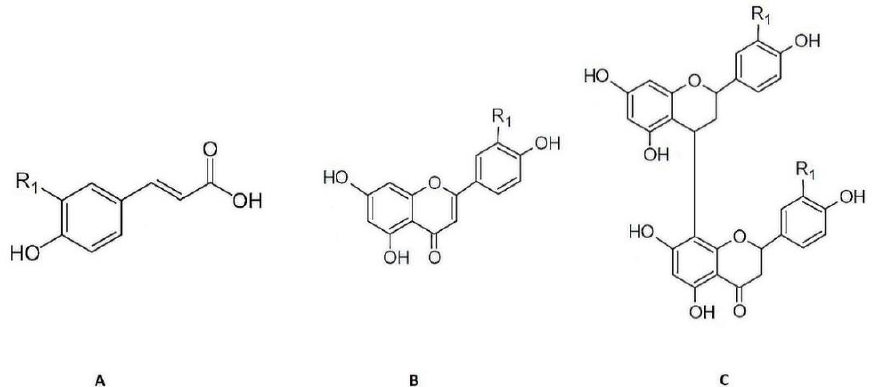
Figure 1. Chemical structure of the principal phenolic compounds present in aqueous extracts of Cymbopogon citratus leaves: ( A ) Hydroxycinnamic acid derivatives of caffeic (R 1 = OH), ferulic (R 1 = O-CH 3 ), and p -coumaric (R 1 = H) acids; ( B ) flavone derivatives of luteolin (R 1 = OH) and apigenin (R 1 = H); ( C ) flavan derivatives of luteoliflavans (R 1 = OH) and apigeniflavans (R 1 = H) (all the structures were obtained from Marvin version 21.17.0, ChemAxon (https://www.chemaxon.com, (accessed on 7 September 2022)).